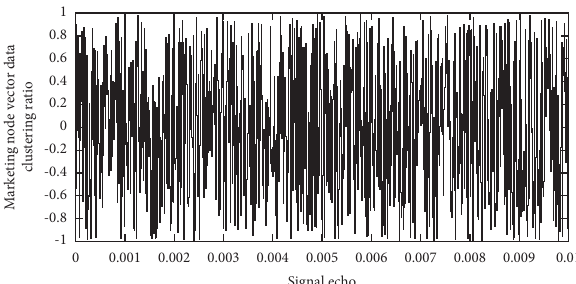
Figure 8: Vector data clustering curve of marketing nodes.